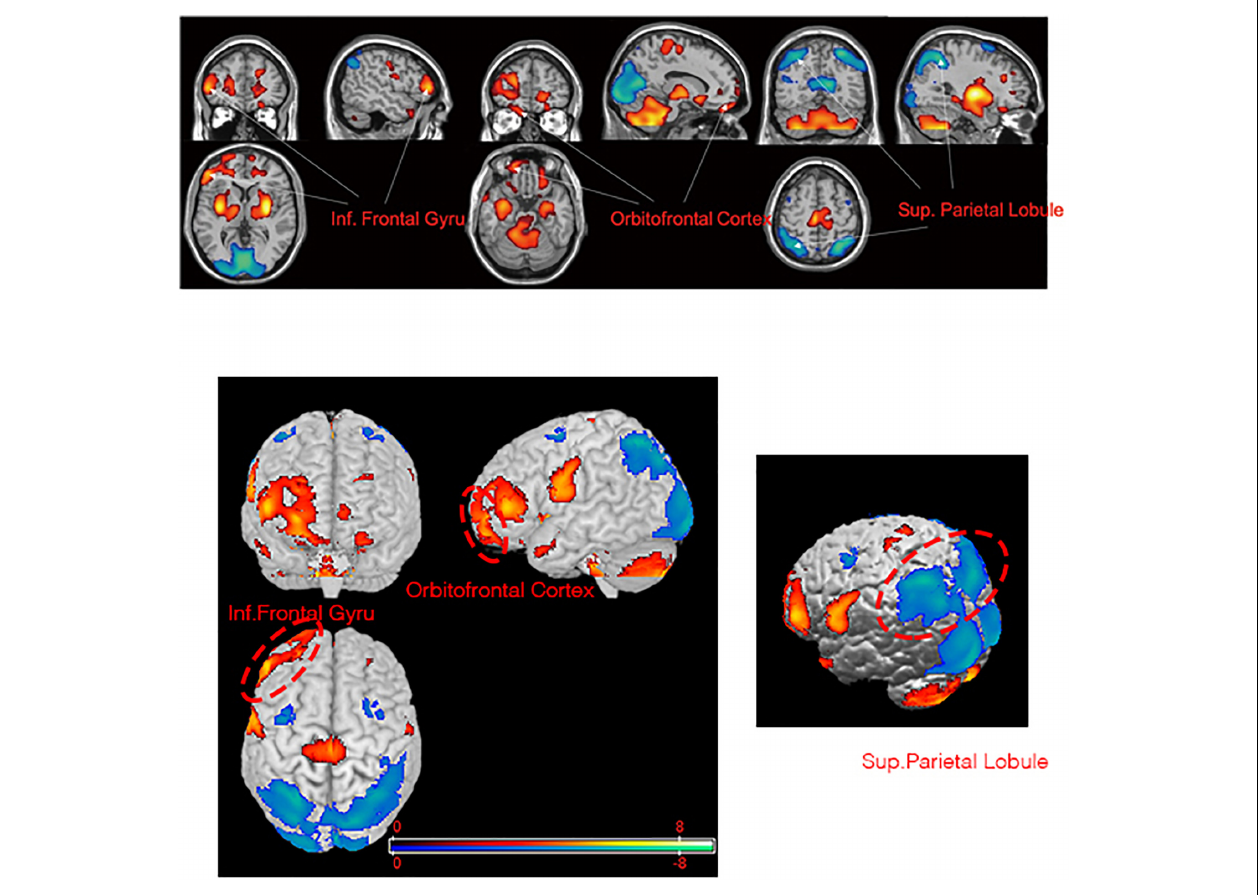
FIGURE 1 | Brain regions with significant metabolic differences in PD-TRD patients versus normal individuals (i.e., the health controls). Glucose metabolism in PD-TRD patients is increased (red) in the right OFC and bilateral inferior frontal gyrus and is decreased (blue) bilaterally in the superior parietal gyrus.